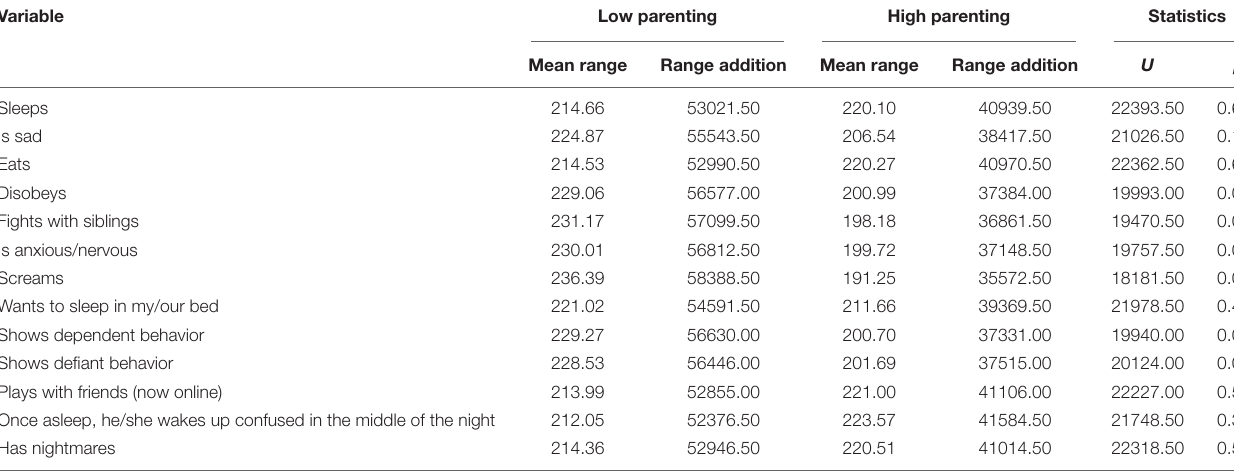
TABLE 4 | Change in children’s behavior according to the level of positive parenting.